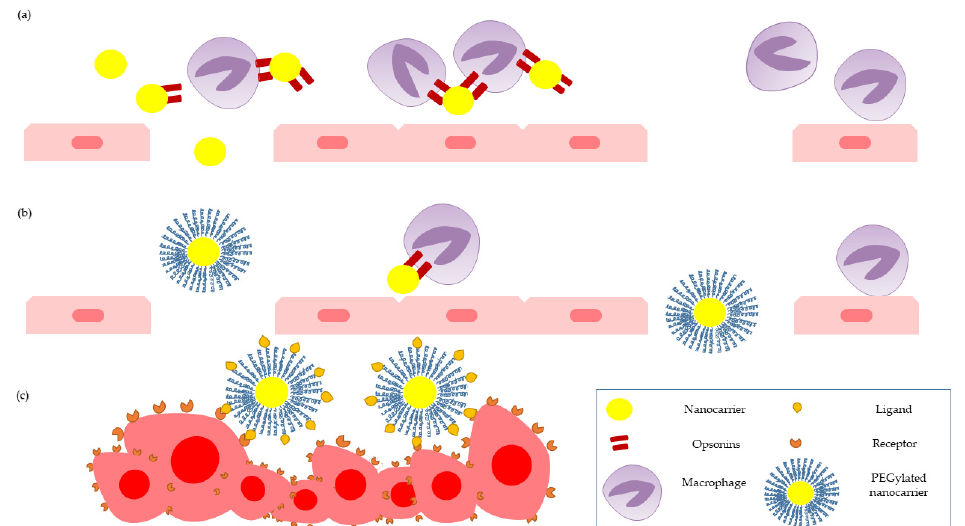
Figure 6. Nanocarrier-based drug delivery system for targeted and tumor-specific therapy: attaching opsonins to the “pure” surface of nanocarriers and reticuloendothelial system (RES) activation ( a ); passive targeting of PEGylated nanocarriers ( b ); active targeting of PEGylated and ligand-functionalized nanocarriers ( c ).